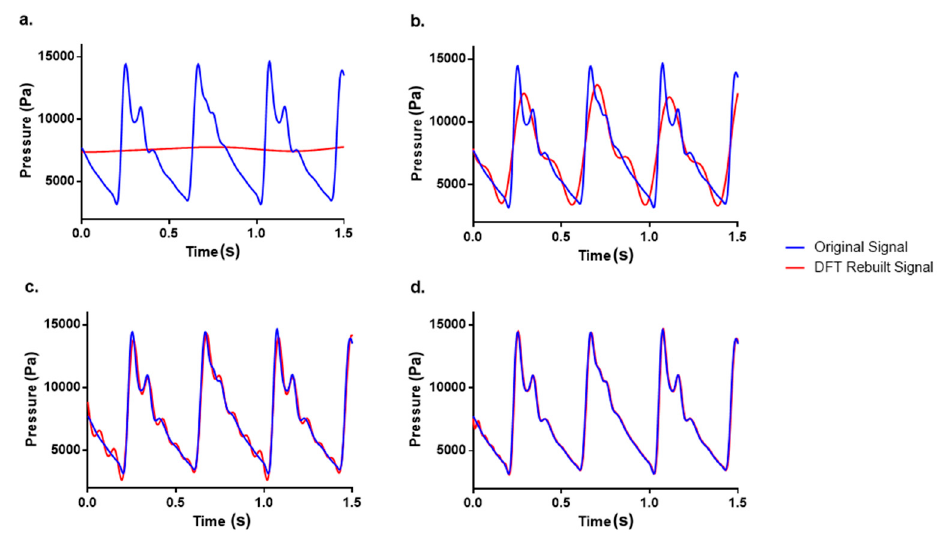
Figure 11. Comparison between the experimental Outlet pressure signal and the reconstructed DFT signal: ( a ) 10 harmonics, ( b ) 50 harmonics, ( c ) 100 harmonics, and ( d ) 150 harmonics.